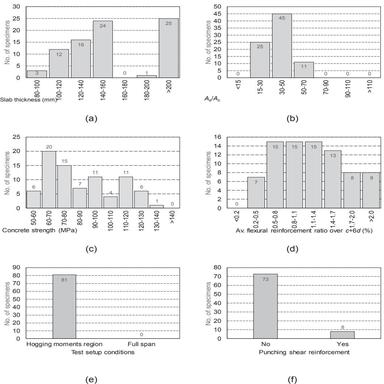
Histograms of tested parameters in monotonic punching tests of non-prestressed flat slab specimens with normal-weight HSC: a) specimen thickness; b) ratio As/Ac; c) concrete strength; d) average flexural reinforcement ratio; e) test setup conditions; f) presence of punching shear reinforcement.